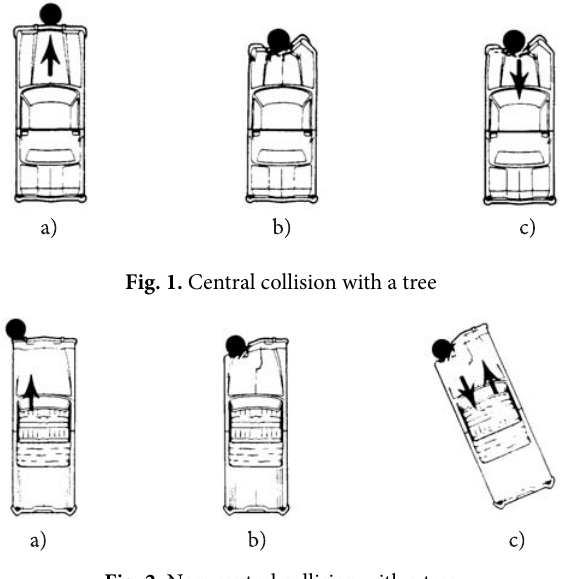
Fig. 2. Non-central collision with a